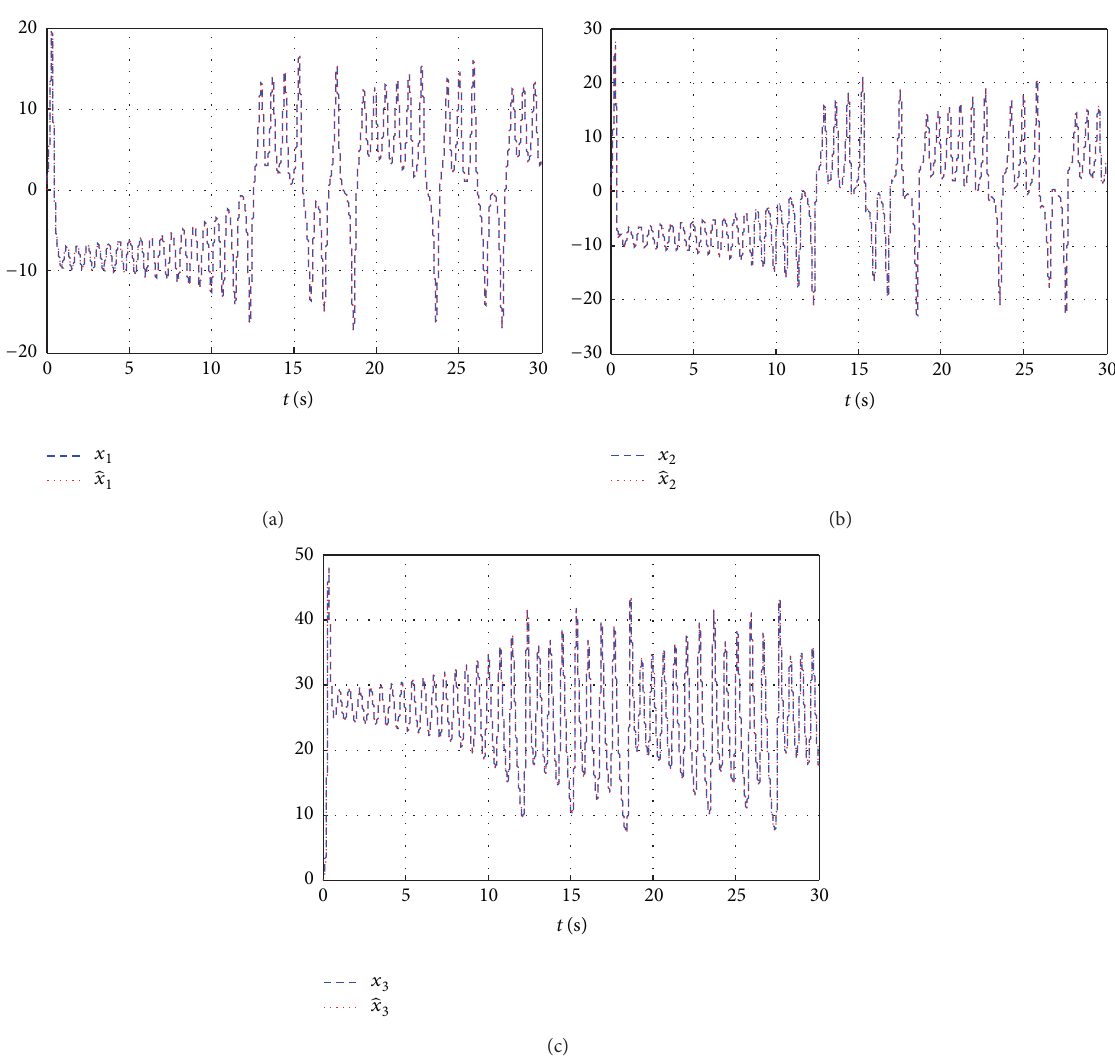
Figure 3: (a) The state 𝑥 1 (𝑡) and its estimated ̂𝑥 1 (𝑡) . (b) The state 𝑥 2 (𝑡) and its estimated ̂𝑥 2 (𝑡) . (c) The state 𝑥 3 (𝑡) and its estimated ̂𝑥 3 (𝑡) .